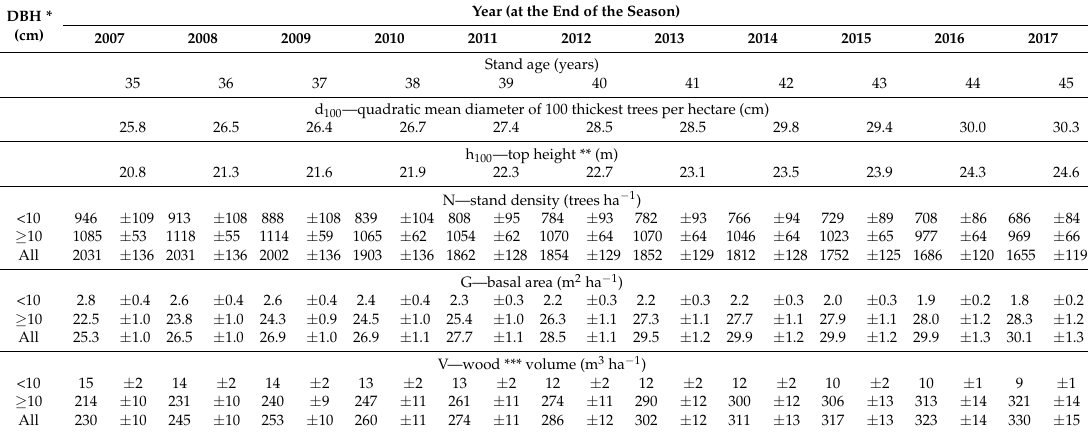
Table 2. Temporal evolution of d100, h100 stand density, basal area and wood volume of the forest in the area around the eddy covariance tower (mean ± std.